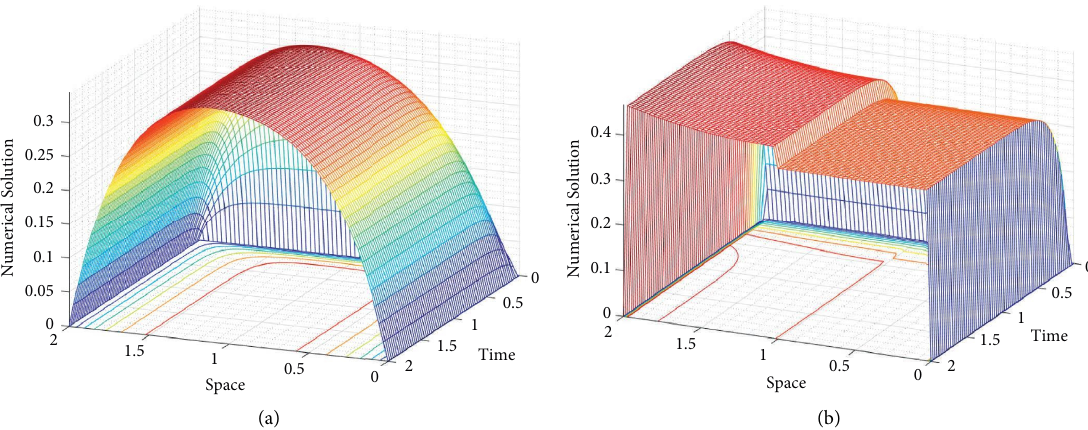
Figure 4: Surface plots for the numerical solution of Example 2 for N � 128 and M � 64. (a) [ ε � 2 0 ], (b) [ ε � 2 − 14